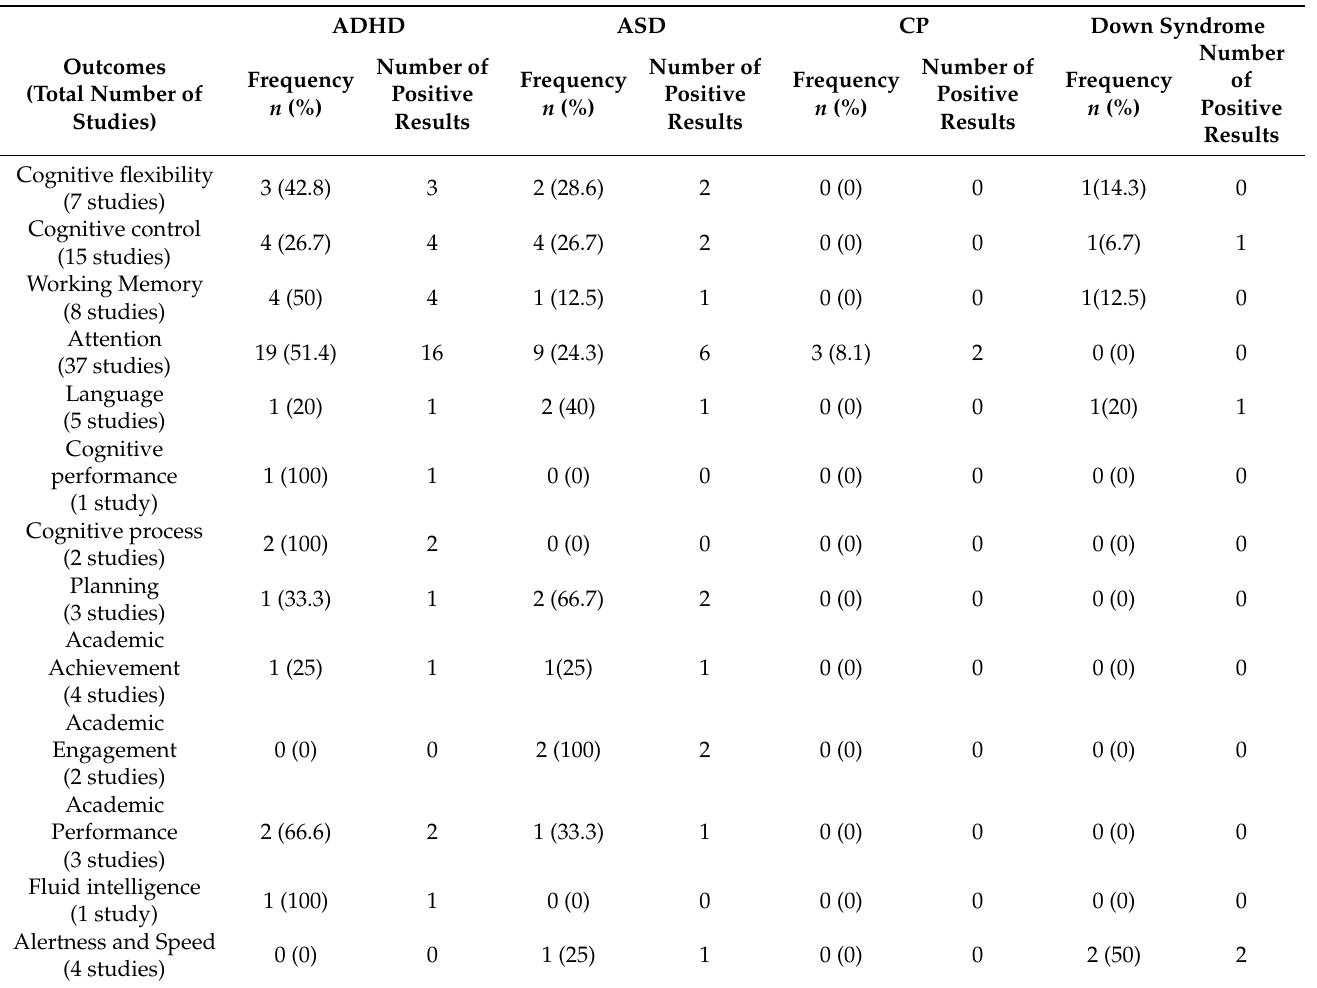
Table 3. Frequency of cognitive outcomes assessed in children with attention-deficit/hyperactivity disorder (ADHD), autism spectrum disorder (ASD), cerebral palsy (CP), and Down syndrome, and the direction of change. ADHD ASD CP Down